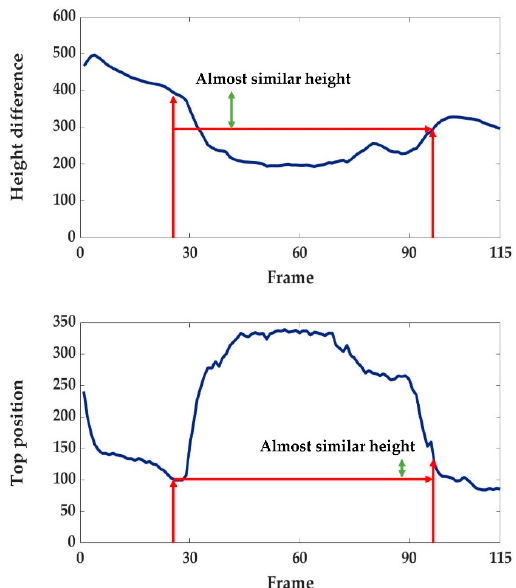
Figure 12. Fall detection features applied to detect the normal state.